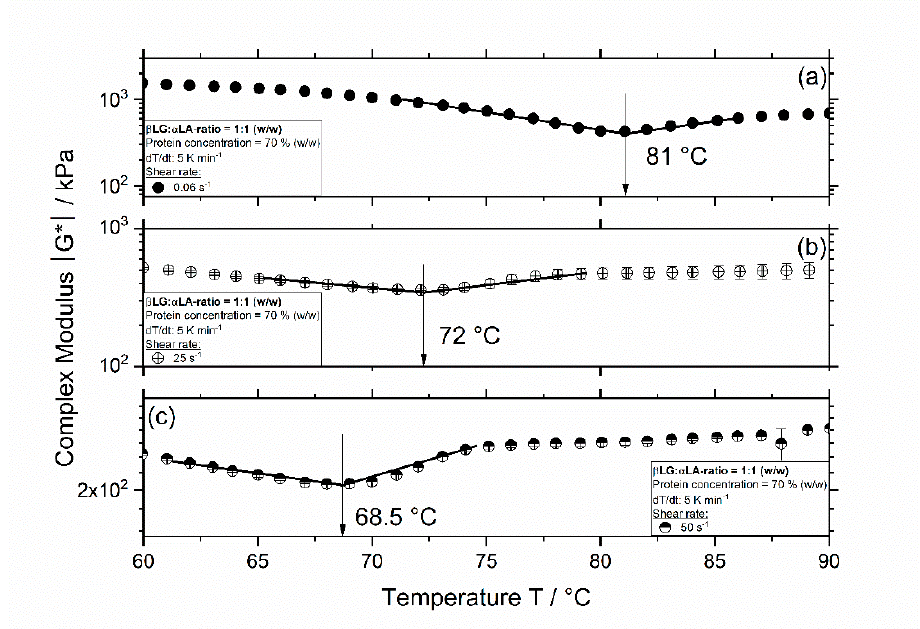
Figure 2. Complex modulus | G ∗ | as a function of temperature for 1:1 systems with a concentration of 70% ( w / w ) and a shear rate of 0.06 s − 1 ( a ), 25 s − 1 ( b ), and 50 s − 1 ( c ). Measurements were performed at a constant heating rate of 5 K min − 1 , bars represent standard deviation (SD).